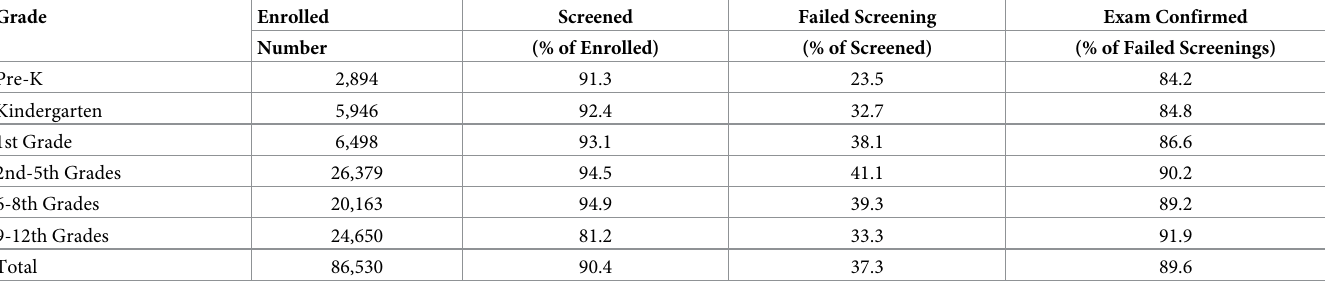
Table 6. Rates of screenings, failed screenings, follow-up, and confirmed exams in community schools by grade, 2018–19. Grade